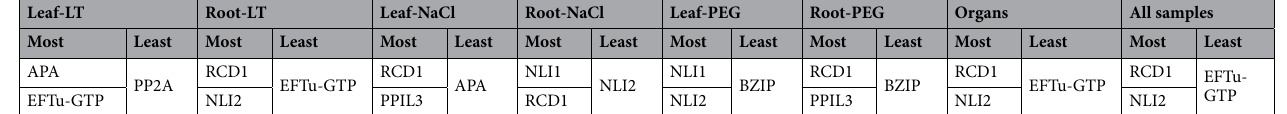
Table 5. Most stable and least stable reference genes according to